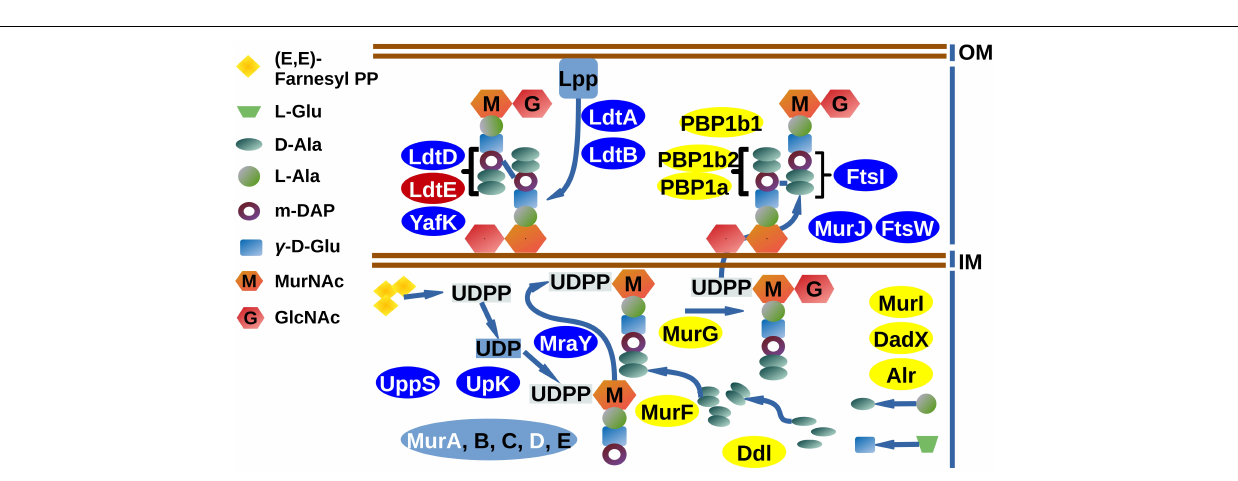
FIGURE 6 | cKD24 mutant showed DEGs in the canonical cell division pathway for alphaproteobacteria. DEGs in the cKD24 mutant that were downregulated (blue ovals) or upregulated (red ovals) with a cutoff threshold of log2FC ≥ 1.5 and P-adj/FDR ≤ 0.02. Non-DEGs are shown in yellow ovals. TolB (in white letters) was the only downregulated gene in the Tol-Pal complex (light blue oval). The cell division pathway was based on the KEGG pathway map for Cell cycle in C. crescentus.